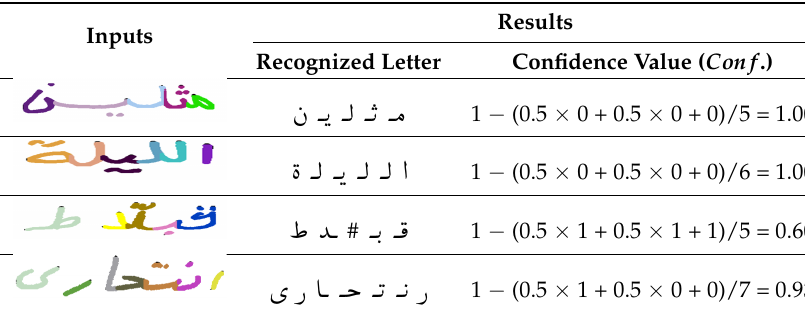
Table 1. Examples of the inputs and the results of the HMM-based recognition approach. Notice in the third row the third segment (from the right) is rejected; hence it is replaced with #. Furthermore, the first segment (from the right) in the fourth row is recognized as “ (cid:80) ” with a 50% possibility of substitution